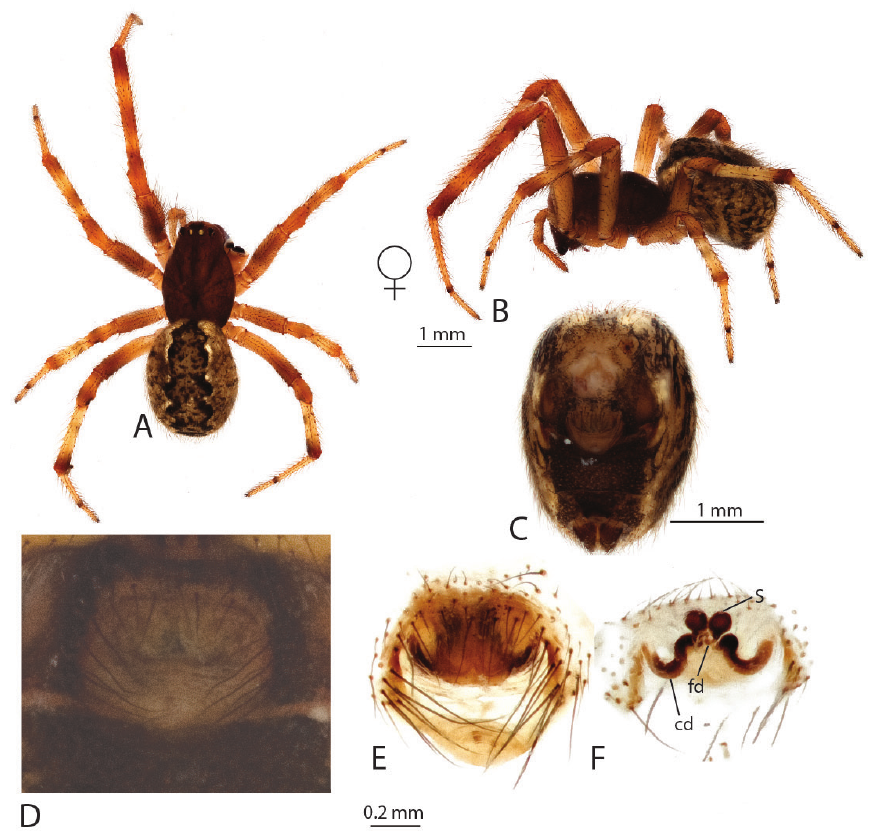
Figure 13. Anelosimus wallacei : A–B female dorsal and lateral views C abdomen ventral D epigynum ventral view E epigynum cleared ventral F epigynum cleared,